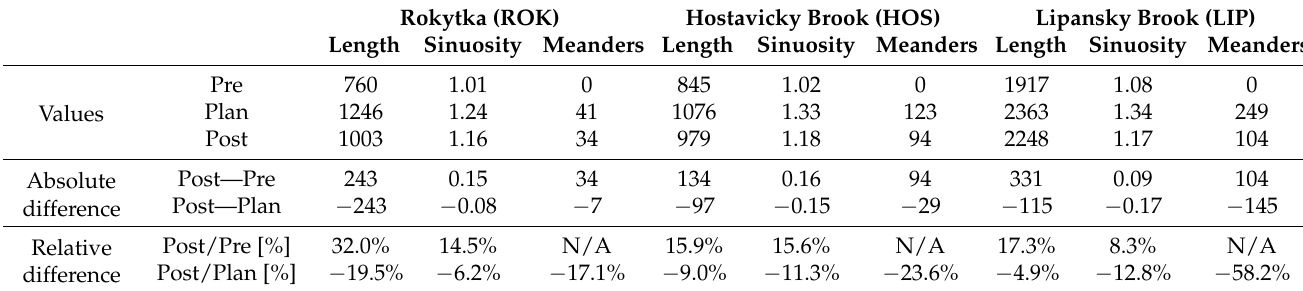
Table 4. Differences in geometric properties of the restored streams, comparing the initial status and the planned and realized restoration. Rokytka (ROK) Hostavicky Brook (HOS) Lipansky Brook